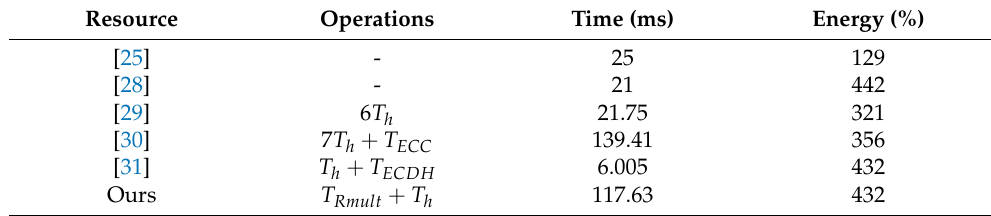
Table 9. Comparison of operations made by the IoT